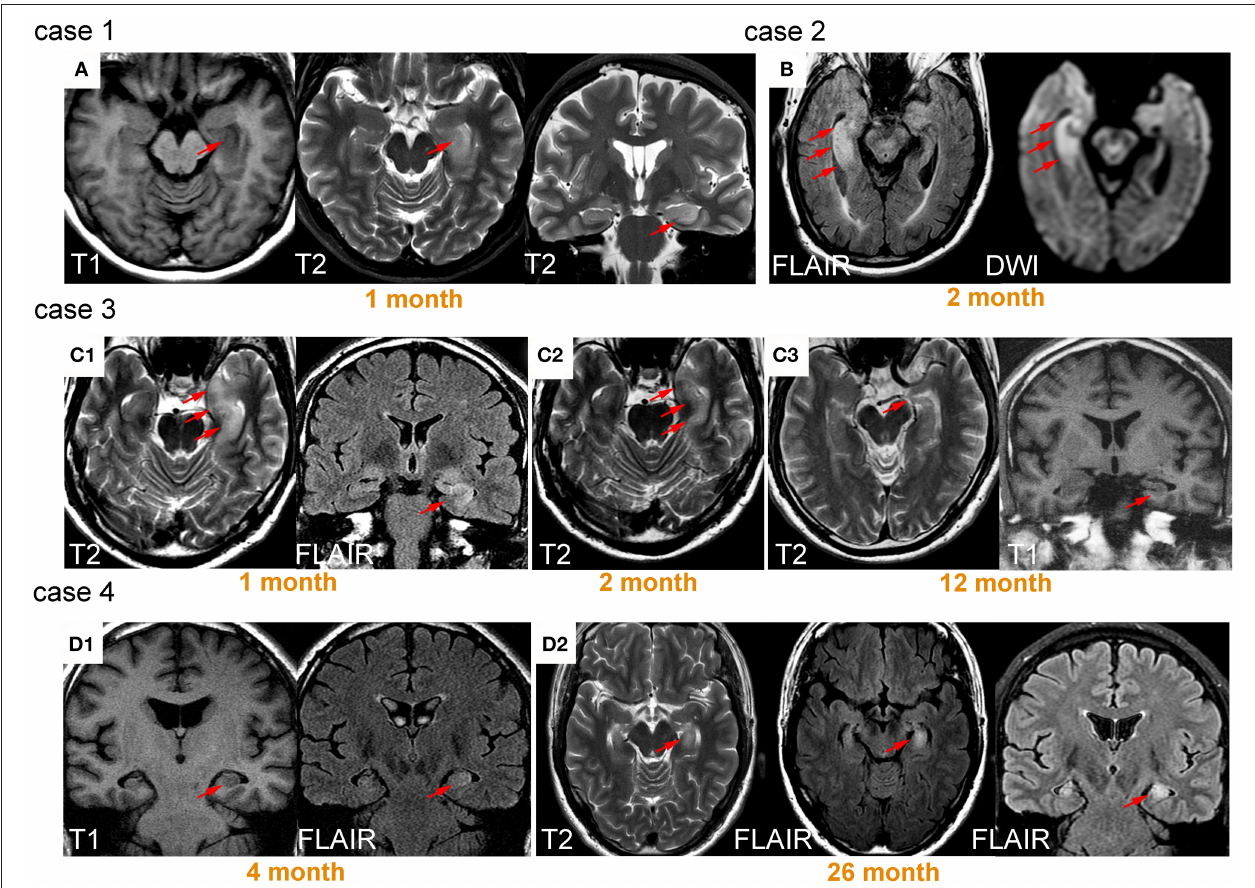
FIGURE 3 | Lesions on medial temporal lobe and their signal change over time. Case 1 was a 59-year-old female patient presenting with memory impairment and seizure. T1 hypointensity and T2 hyperintensity accompanied by swelling were observed on left medial temporal lobe (MTL) 1 month after onset (A) . Case 2 was a 73-year-old male patient who presented with seizure for 2 months, exhibiting prominent right MTL swelling and hyperintensity (B) . Case 3 was a 52-year-old male patient with seizure. Hyperintensity and swelling in left MTL was observed 1 month after onset (C1) . After treatment with dexamethasone, the patient’s symptoms improved, and the area of signal abnormality decreased (C2) . Twelve months after onset, prominent atrophy occurred (C3) . The patient did not fully recover from memory deficits. Case 4 was a 43-year-old male patient with seizure and memory impairment. Slight swelling and hyperintensity were observed in left MTL (D1) . The patient’s symptoms were not well controlled even after immunotherapy. Swelling and hyperintensity became more prominent 26 months later (D2)